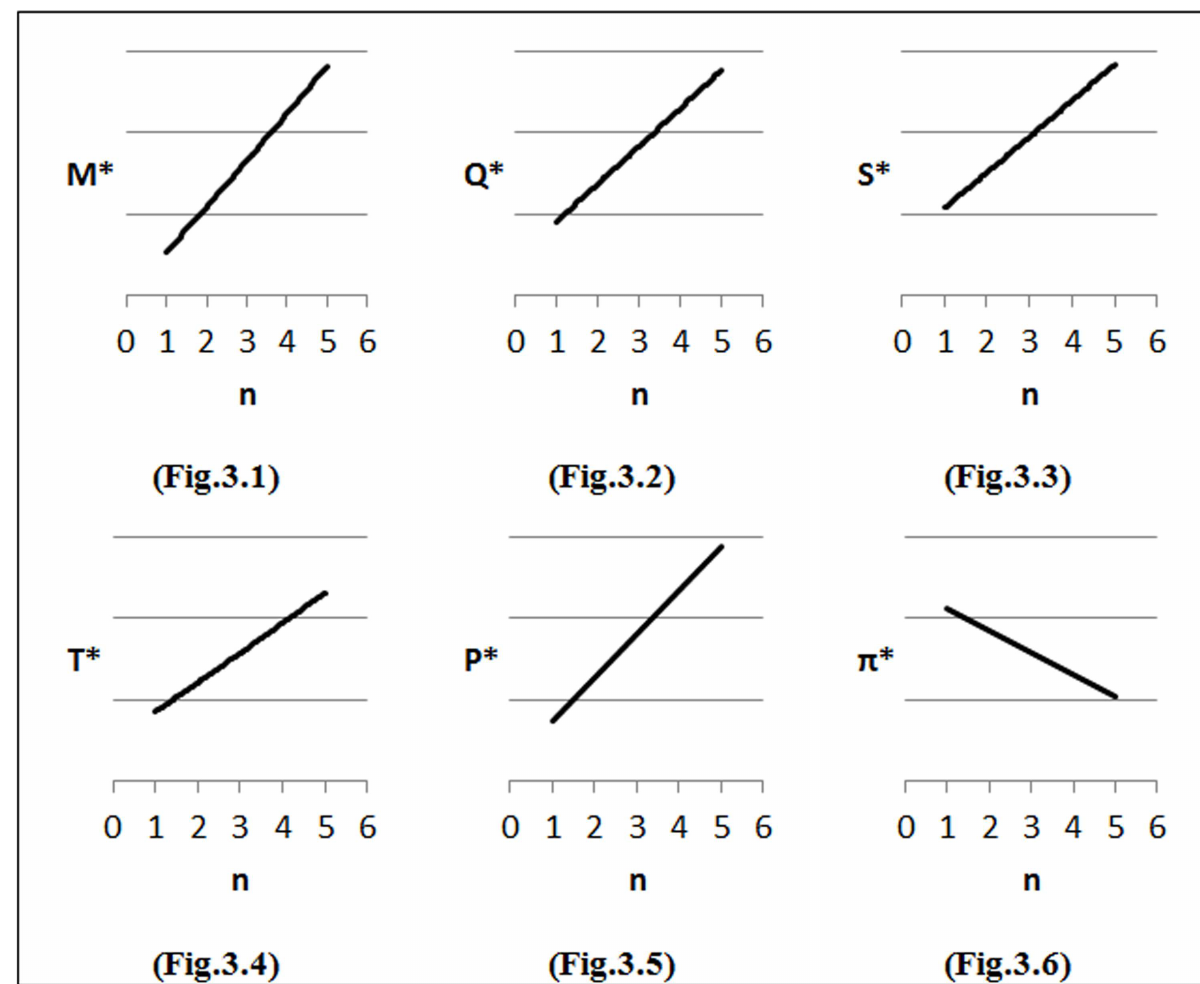
Fig 3. Effects of changes in ( δ ) on decision